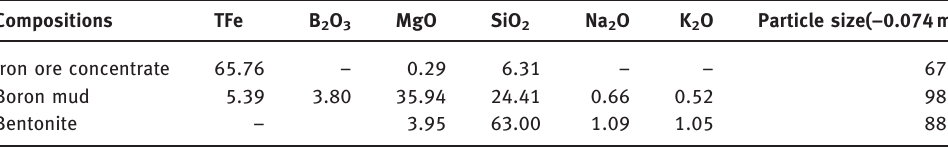
Table 1: Chemical compositions and particle size of experimental materials/%.